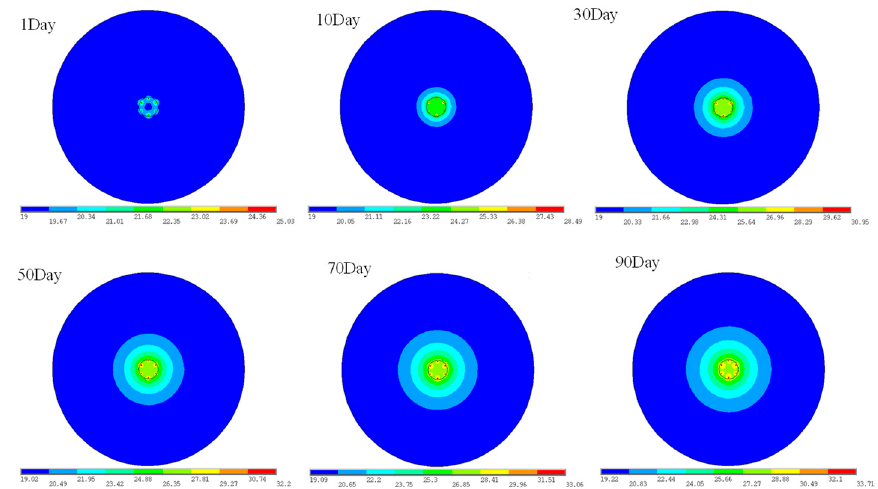
Figure 7. Temperature field evolution of single energy pile under summer conditions. Figure 8a exhibits the temperature changes over time at different locations under intermittent working conditions in summer. The temperature at different locations changes periodically and increases. The inner wall temperature is greater than the external wall, and a lower temperature can be observed if the test point is far from the center of the pile.